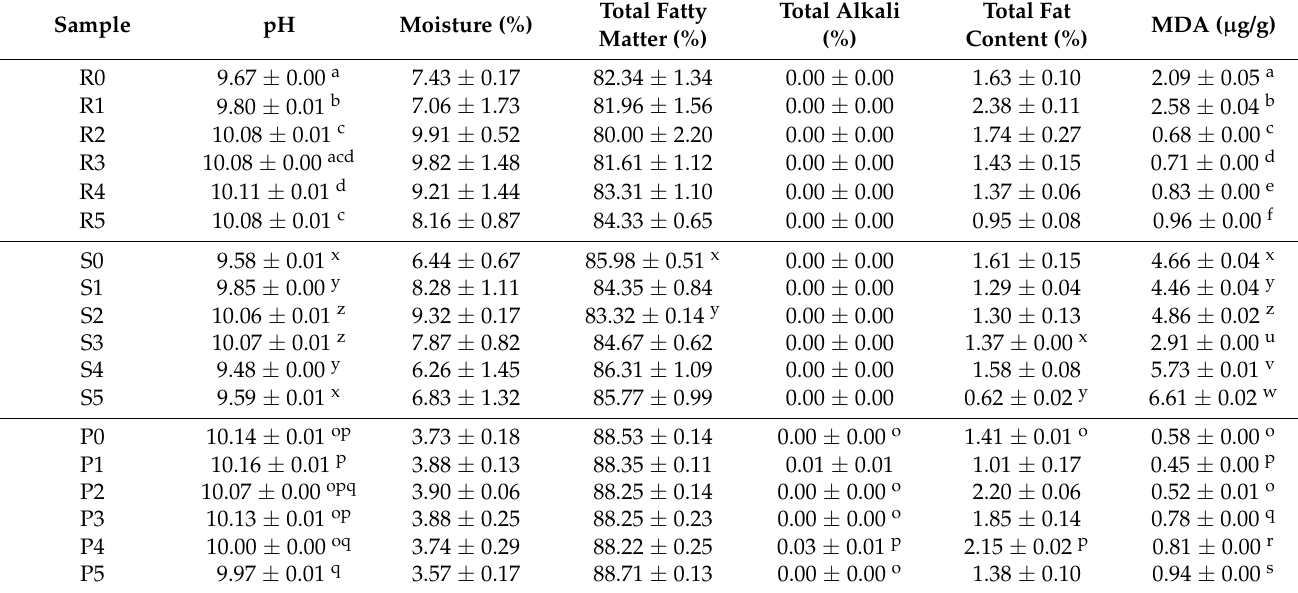
Table 2. Results for pH, moisture, total fatty matter, total alkali, total fat content and MDA for produced soap samples. Sample